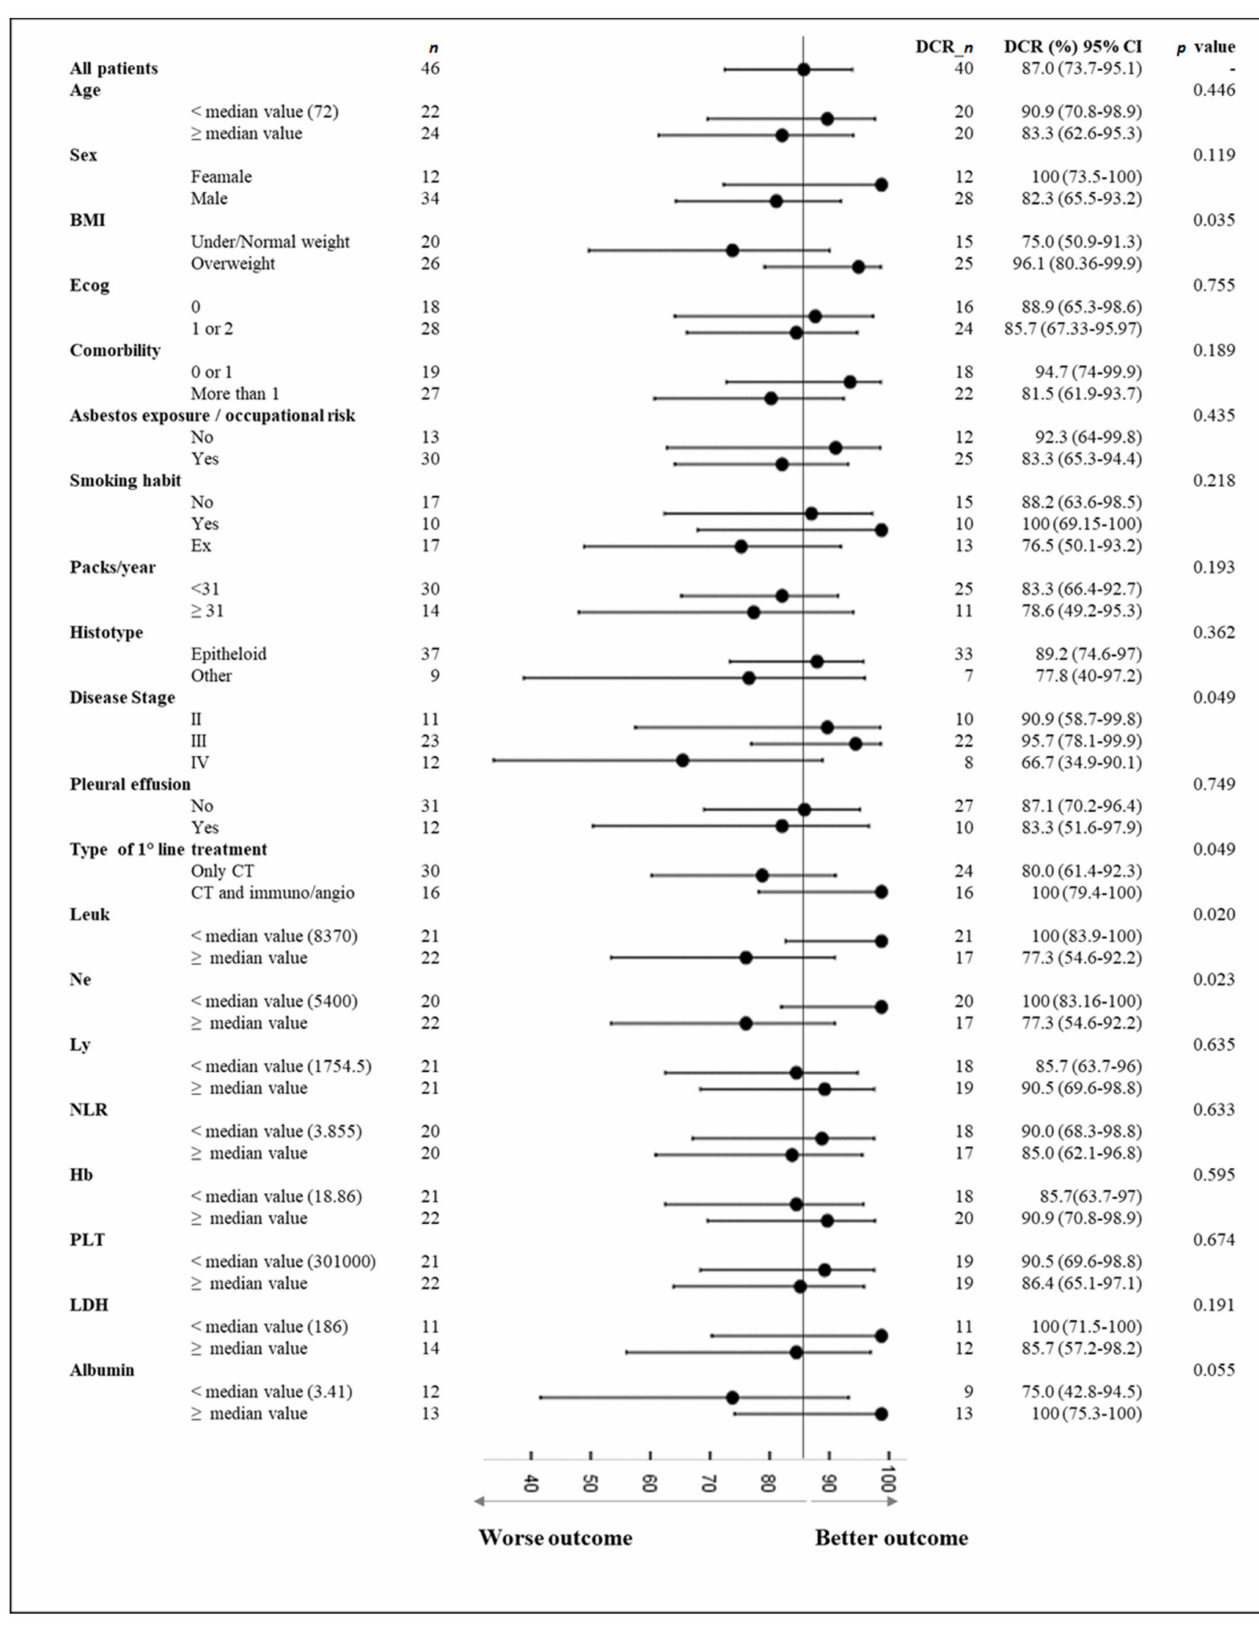
Figure 1. Forest plot of initial disease control rate (DCR) for several characteristics. CI: confidence interval. Abbr.: Leuk: leukocytes; Ne: neutrophils; Ly: lymphocytes; NLR: neutrophil lymphocyte ratio; Hb: hemoglobin; PLT: platelets; BMI: body mass